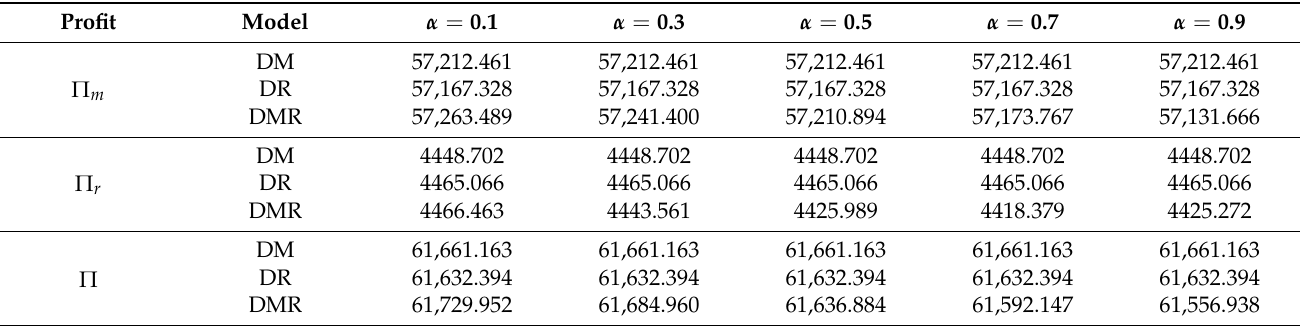
Table 5. Dual-selling